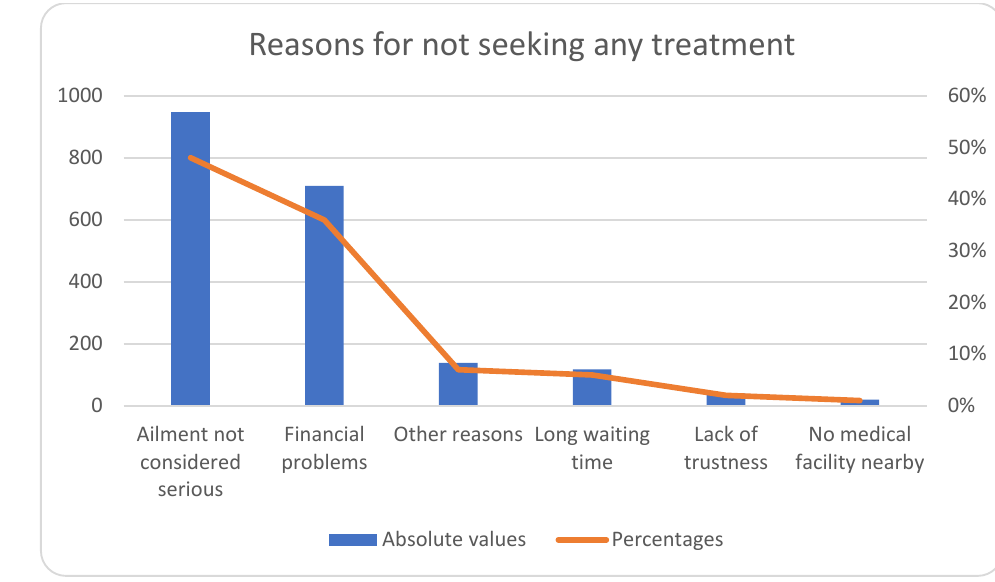
Figure 2. Reasons for non-utilization of healthcare services among people who reported any ailment in the GHDSS cohort ( n = 1974).